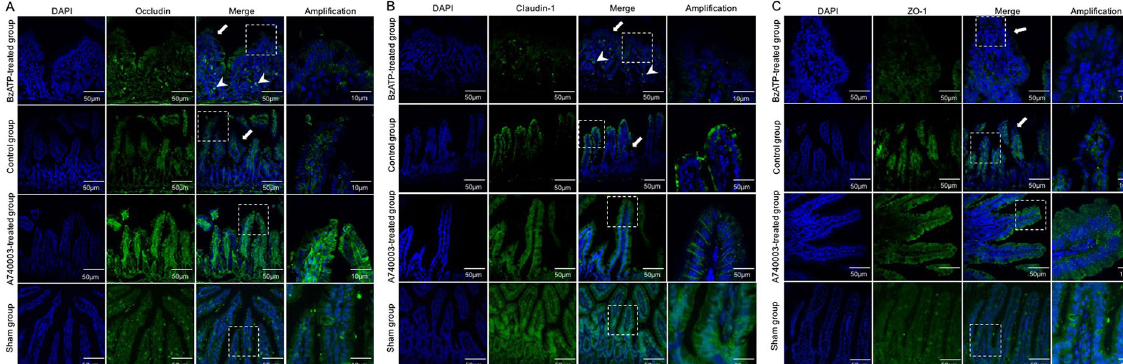
Figure 5. The effects of a P2X7R blockade on TJ distribution. Localization of occludin ( A ), claudin-1 ( B ), ZO-1 ( C ), and DAPI (DNA) within intestinal tissue sections assessed by immunofluorescence at 48 hours after CLP. TJ proteins (green) and DAPI stain (blue), merged TJ proteins and DAPI, as well as amplified merged TJ proteins and DAPI images are presented. Arrows indicate that biotin staining was ectopic to the lamina